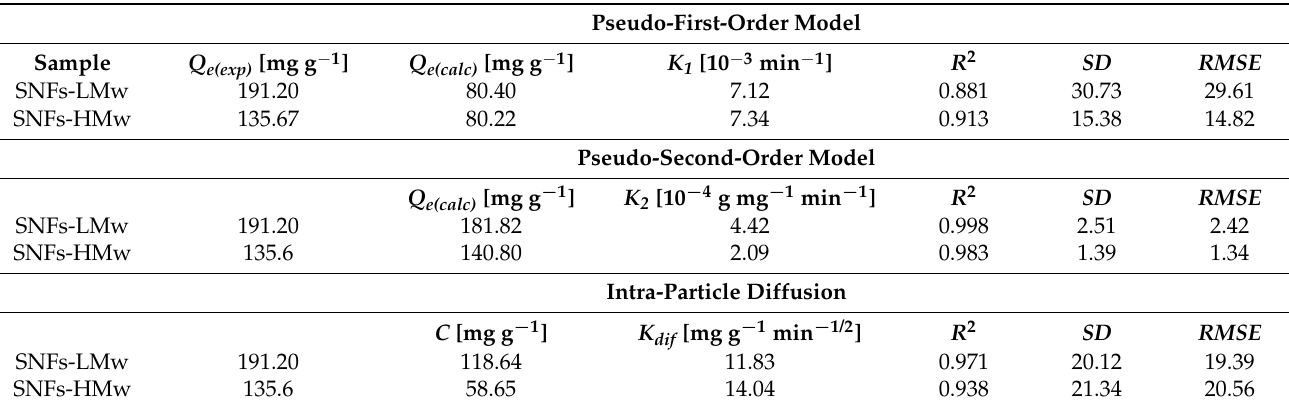
Table 4. Kinetic modeling results of MB adsorption onto SNFs-LMw and SNFs-HMw. Pseudo-First-Order Model